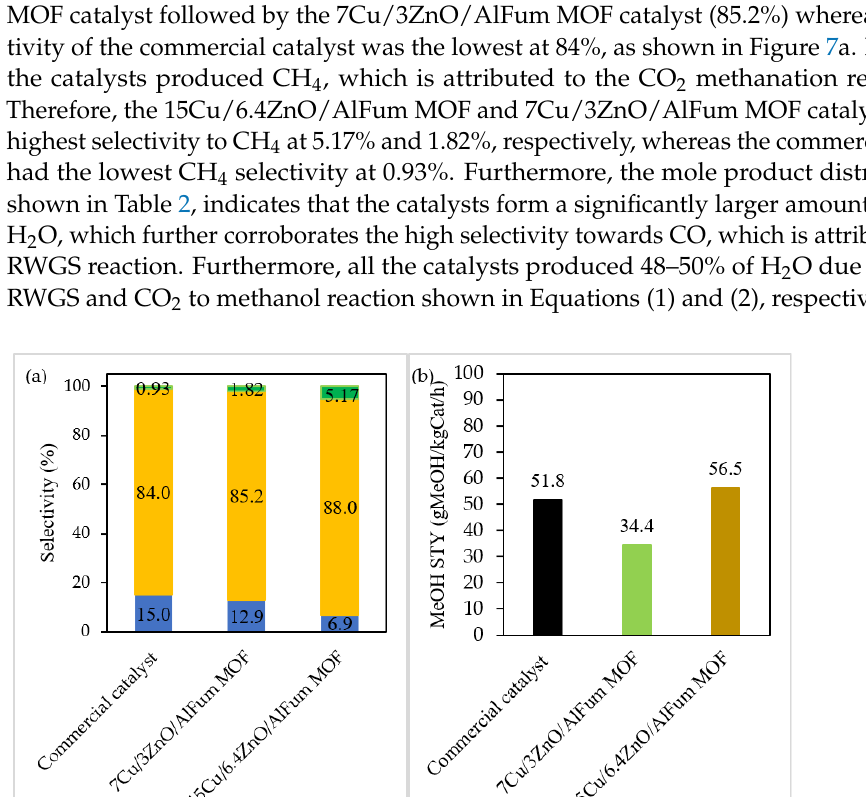
Table 2. Product distribution for all the evaluated catalysts. Product Distribution (mol%) Catalyst MeOH CO CH 4 H 2 O Commercial 12.8 36.0 7Cu/3ZnO/AlFum MOF 15Cu/6.4ZnO/AlFum MOF